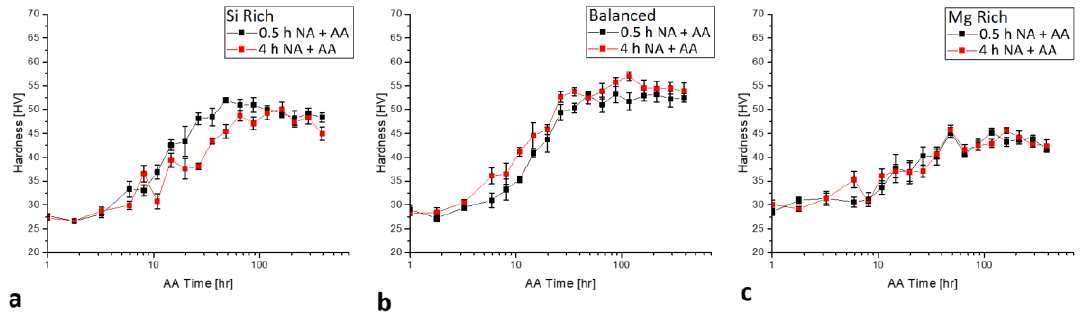
Figure 10. Hardness evolutions during AA in low strength alloys after WQ and variable prior NA, labelled accordingly. Error bars represent 95% confidence.